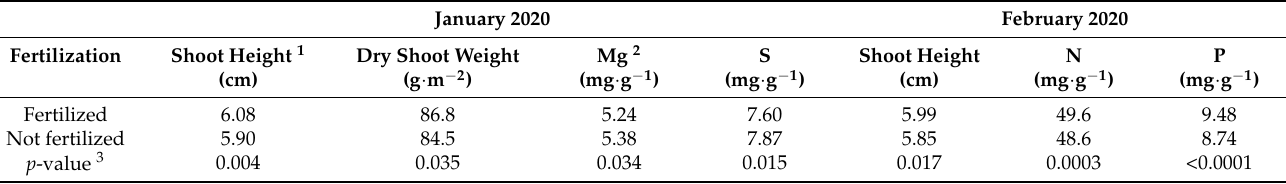
Table 5. Microgreen shoot growth and mineral nutrient concentrations affected by the main effect of post-emergent